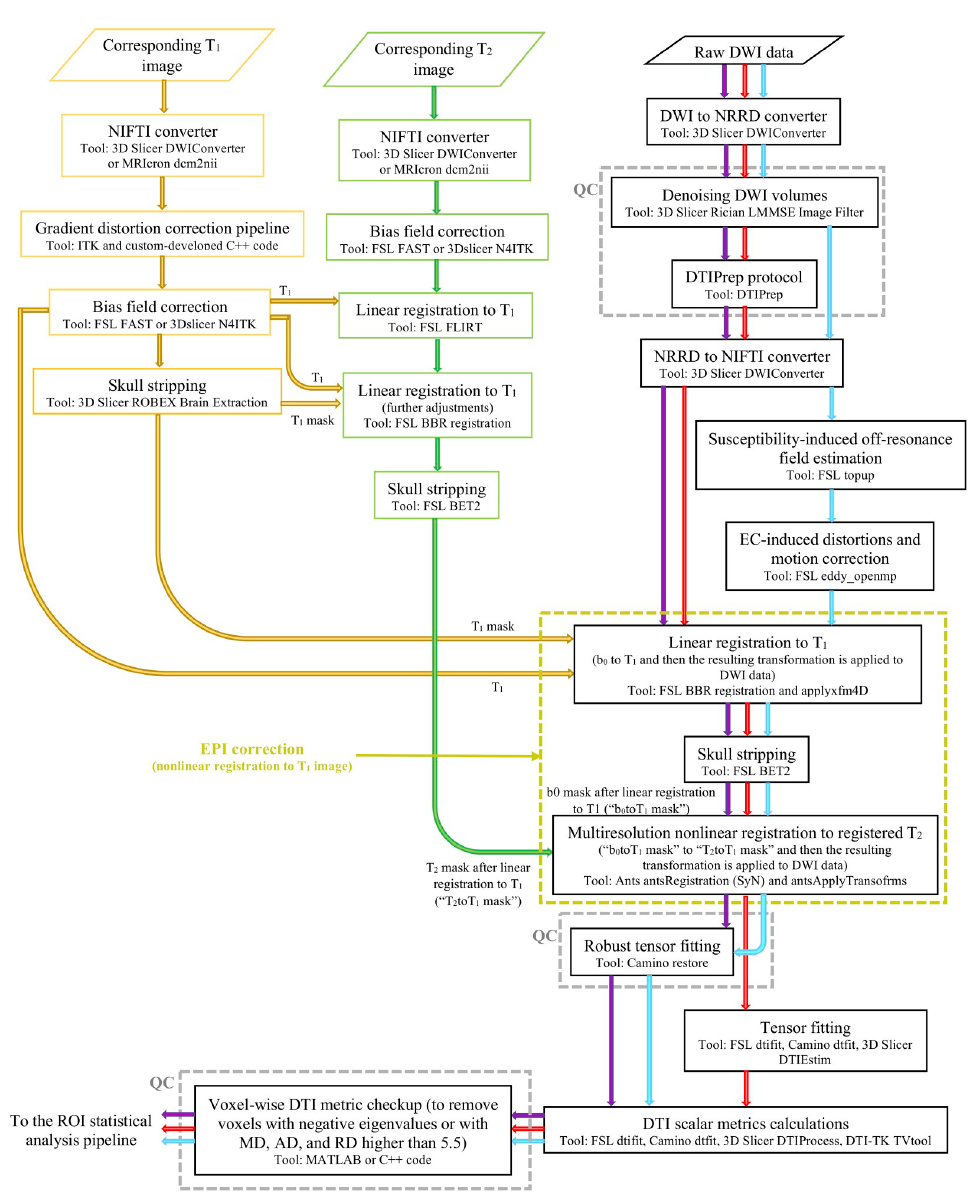
Fig 1. Schematic representation of the three pipelines utilized for brain DTI data processing. The T 1 - and T 2 - weighted imaging processing subpipelines are common to all DTI processing pipelines. The blue, red, and purple arrows depict the 1 st , 2 nd , and 3 rd DTI processing pipelines, respectively. T 1 = T 1 -weighted image, T 2 = T 2 -weighted image, b 0 = b 0